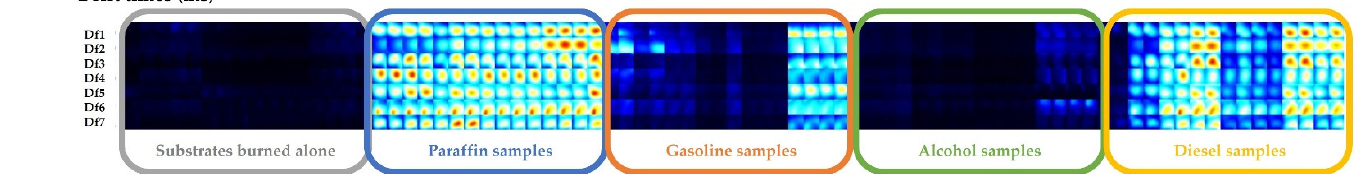
Figure 2. Examples of IMSS fingerprints obtained from the analysis of ILs in fire debris [89] .